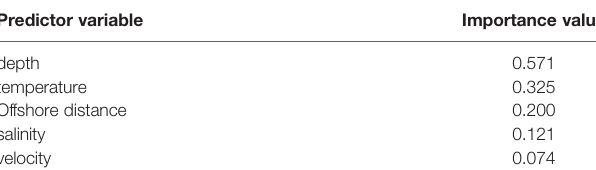
TABLE 1 | Importance values of each environment variable